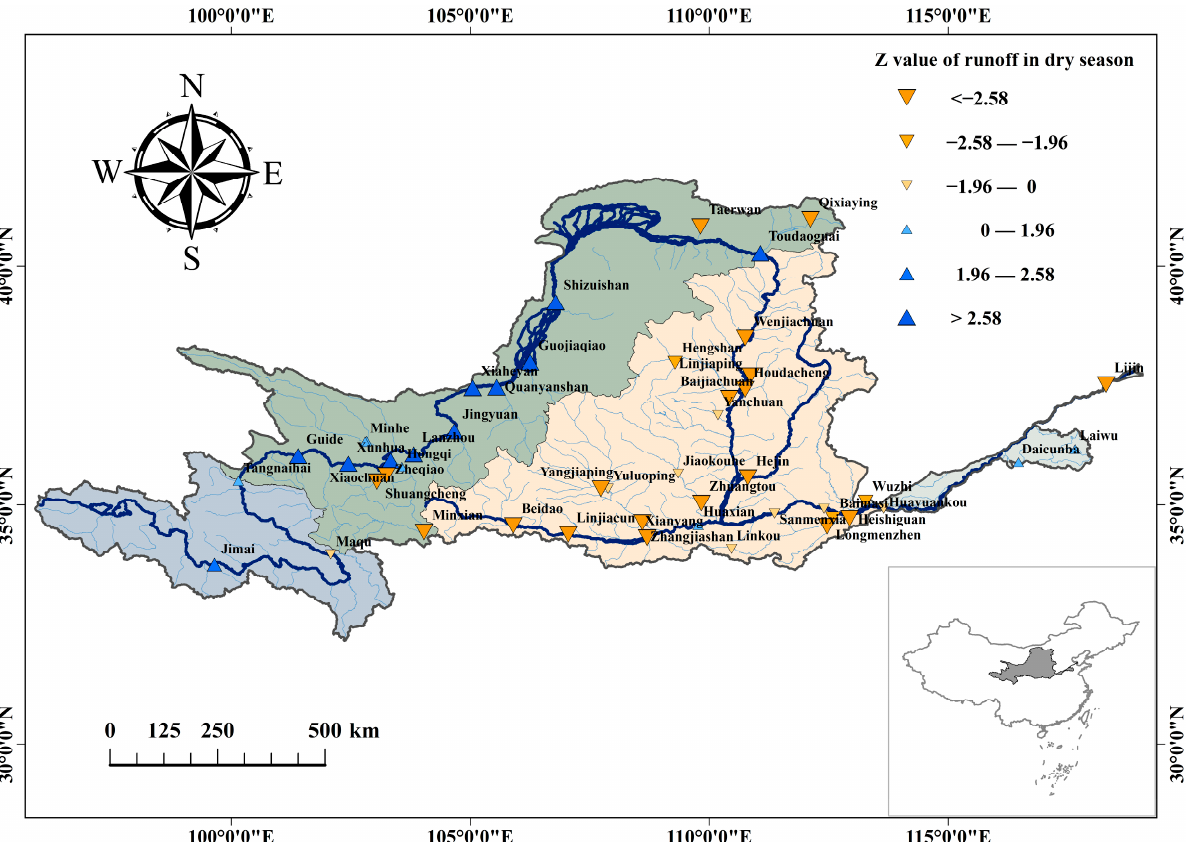
As a result, there was little difference in the runoff concentration of the middle and lower reaches, and the runoff distribution was relatively uniform throughout the year.